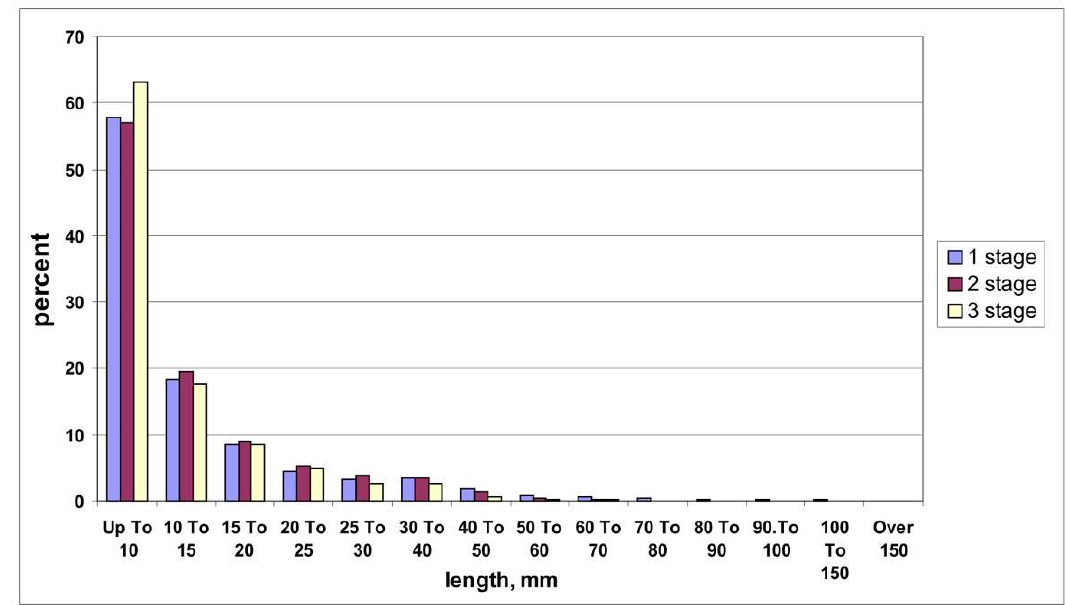
Figure 10. Distribution of size classes of experimental flakes belonging to different reduction